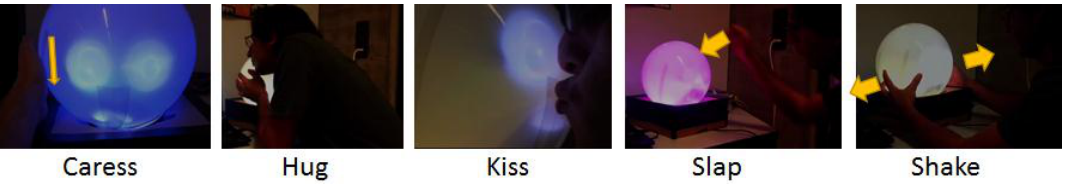
Figure 11. The five gestures of the ADA